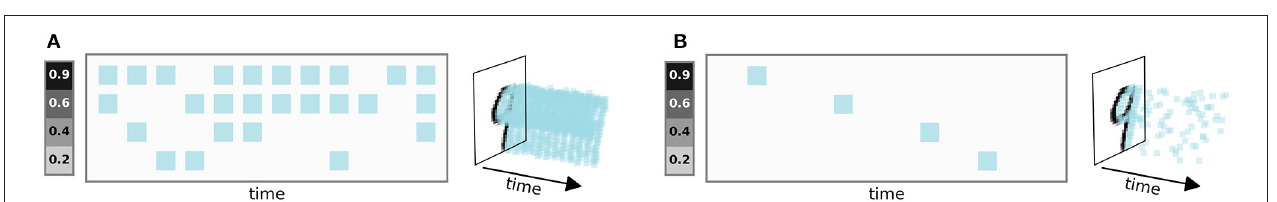
FIGURE 5 | The principle of (A) rate coding and (B) rank order coding, and the spike sequence of an MNIST image after coding.